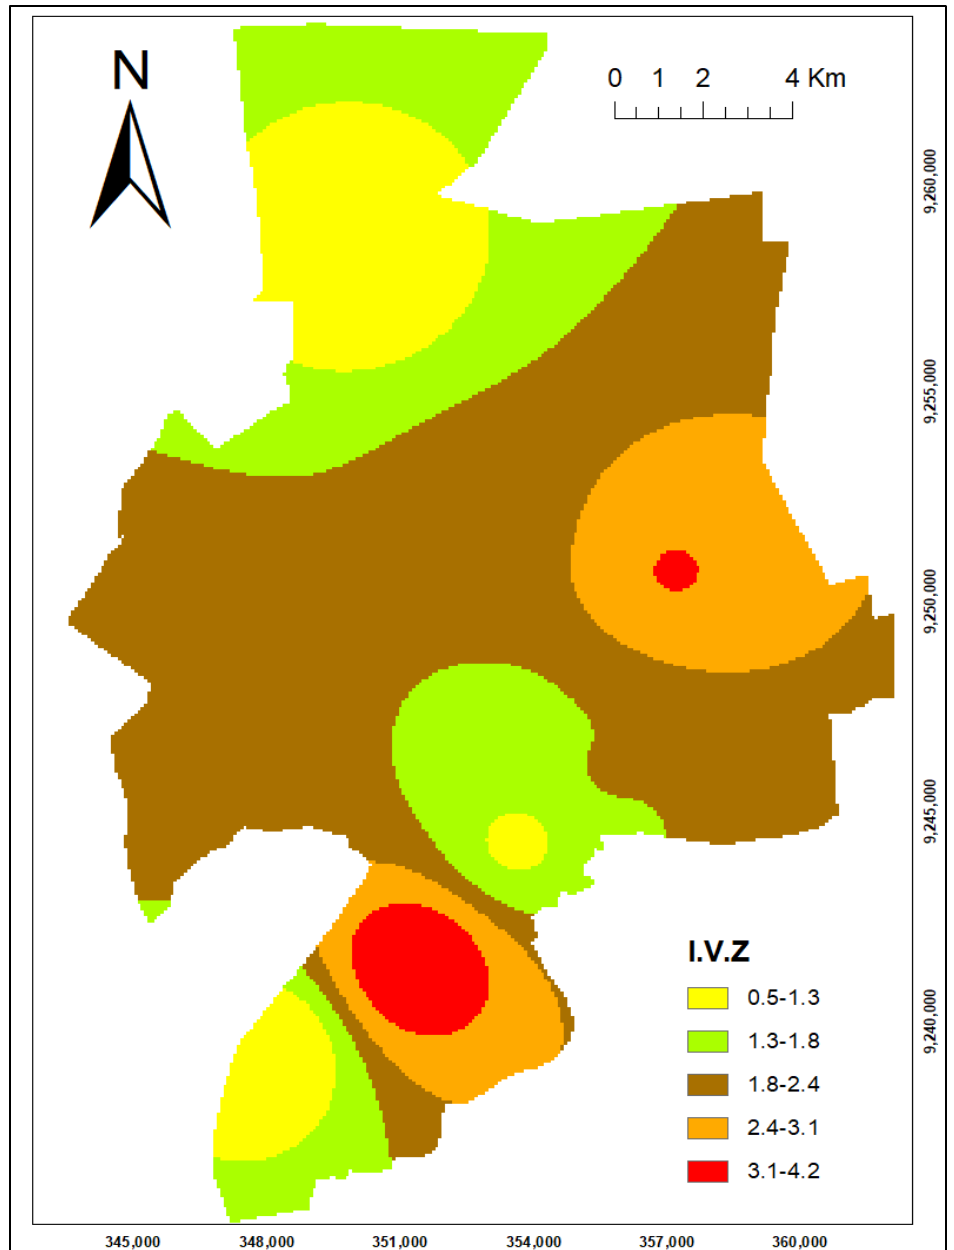
Figure 9. The impact of the vadose zone map.